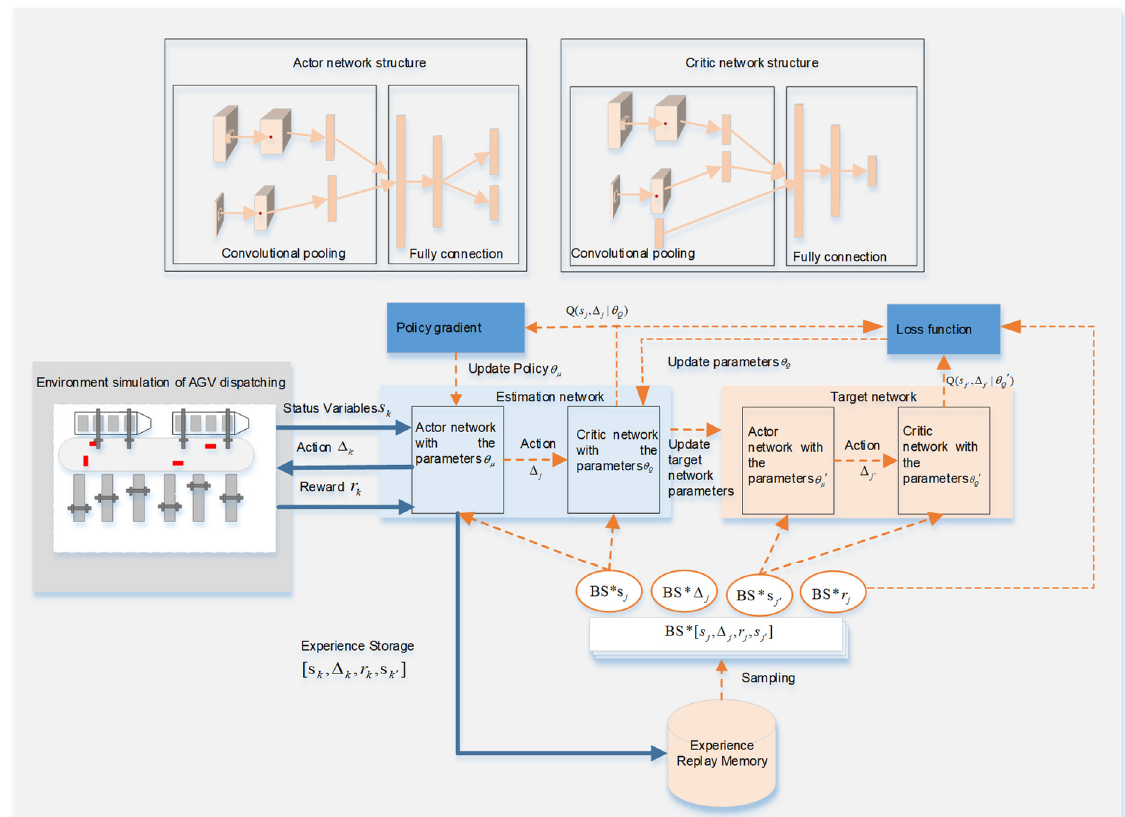
Figure 3. Overview of the CDA algorithm.